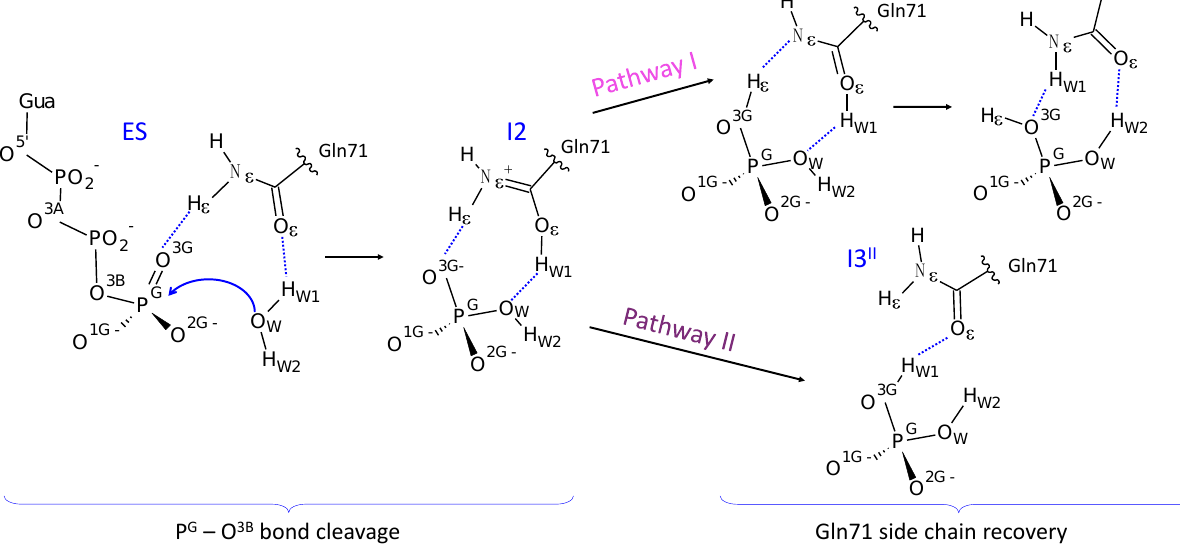
Figure 1. GTP hydrolysis by Arl3-RP2 proposed in [26] (Pathway I) and in this work (Pathway II).